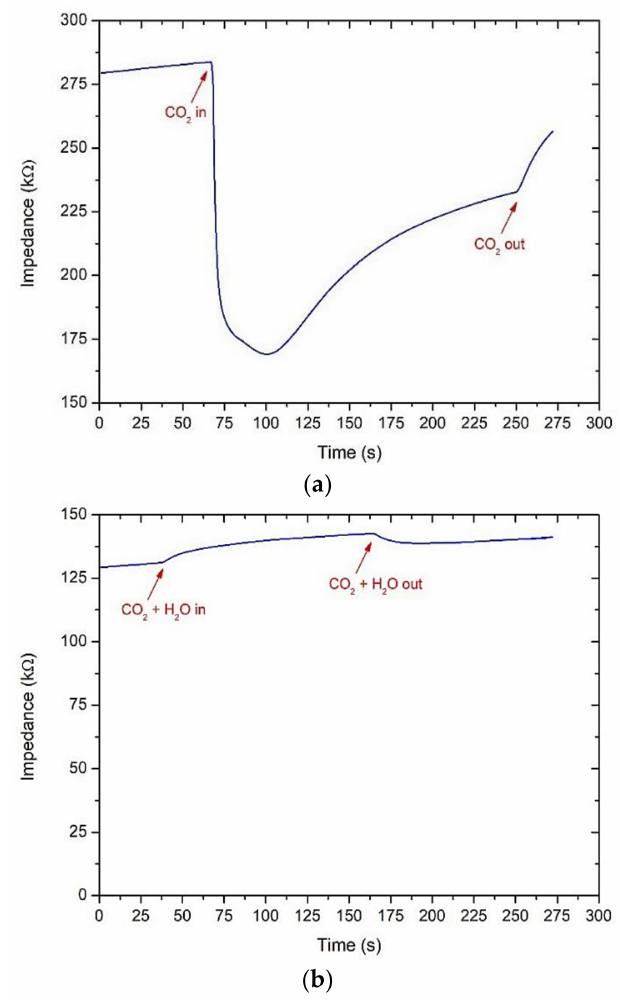
Figure 9. Change of the impedance value for a screen-printed ZnO sensor based on a commercial powder at 200 ◦ C: under dry air ( a ); humid air (75 RH%) and 250 ppm of CO 2 ( b